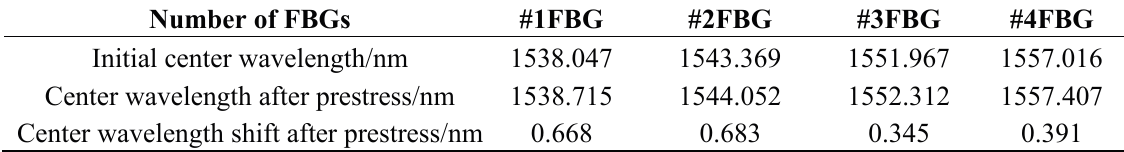
Table 1. Each of the FBG center wavelengths of the triaxial vibration sensor.